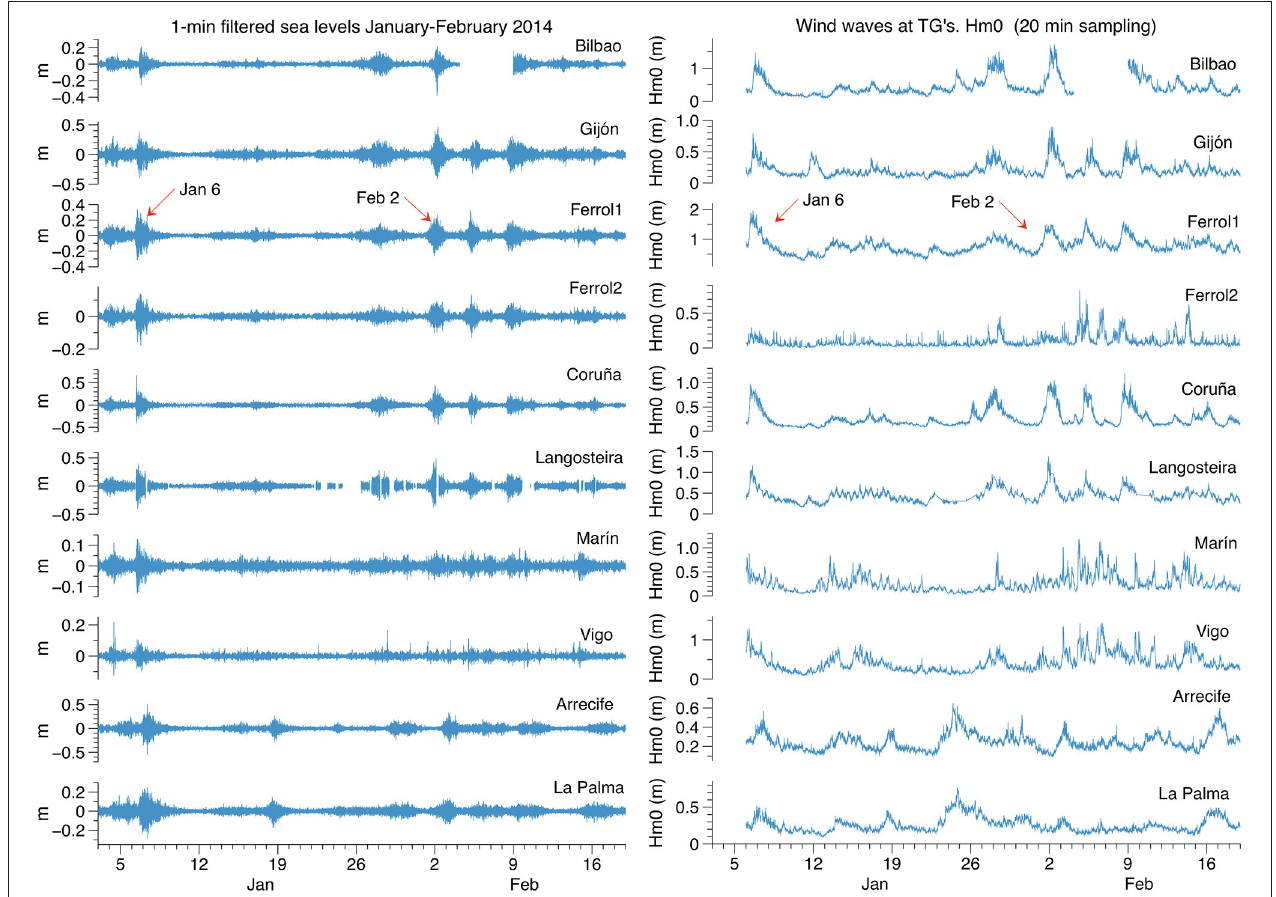
FIGURE 4 | Left: 1min high-pass filtered sea level data from the REDMAR network during the stormy period January- February 2014, showing the occurrence of significant high-frequency sea level oscillations along the Spanish coast; right: significant wave height (H m0 ) computed by these Miros tide gauges for the same